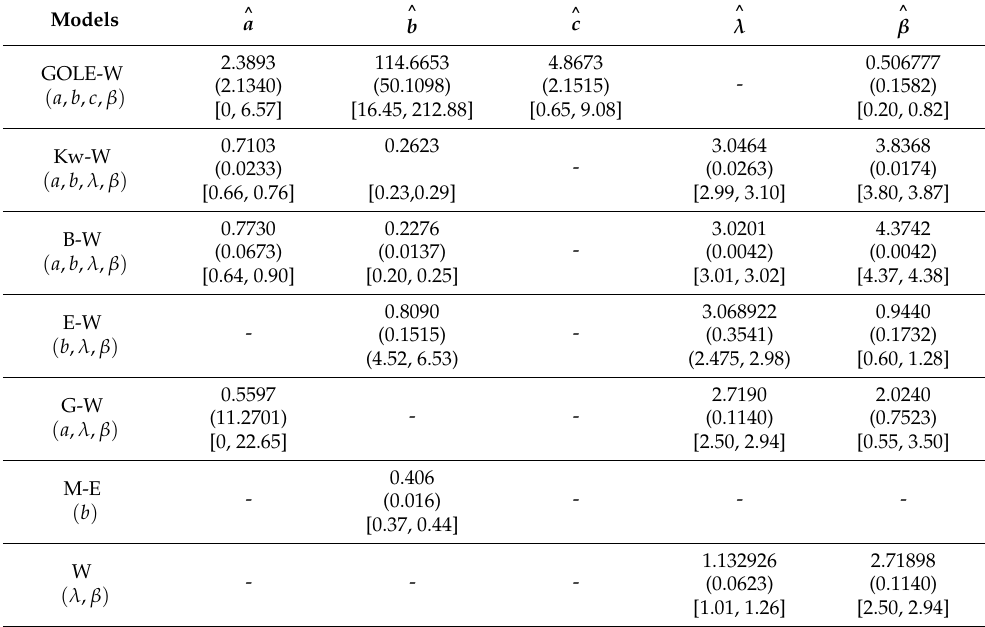
Table 7. MLEs, standard errors (in parentheses) and confidence interval [in brackets] values for data set I.